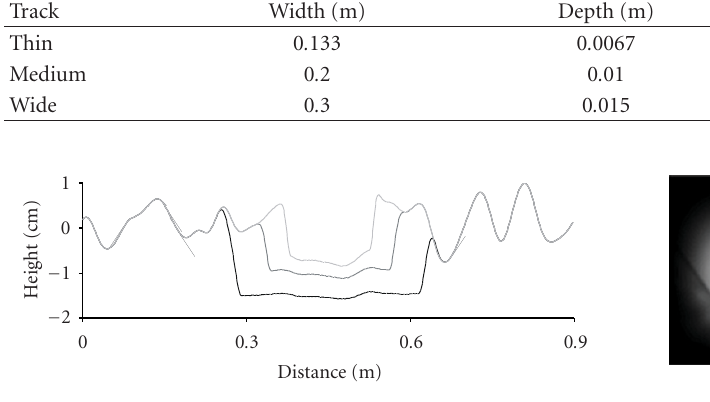
Figure 3: Height profiles recovered at a single range for a single realisation of the thin, medium, and wide tracks described in the text.